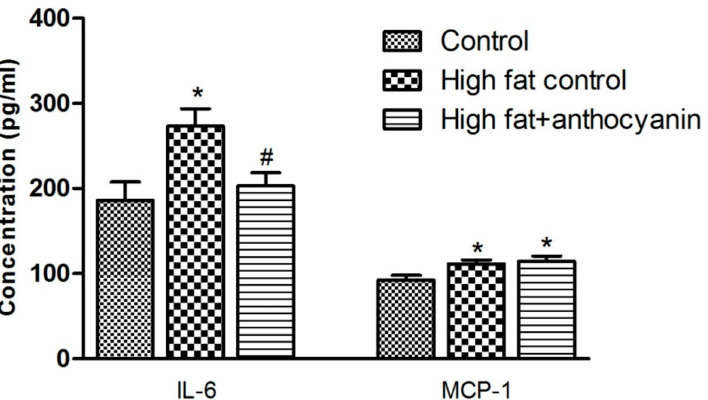
Figure5. E ff ectofchronicanthocyanintreatmentontheplasmalevelsofIL-6andMCP-1. The * indicates a significant di ff erence ( p < 0.05) from the control group. The # indicates a significant di ff erence ( p < 0.05) between the high fat control and the high fat + anthocyanin groups.